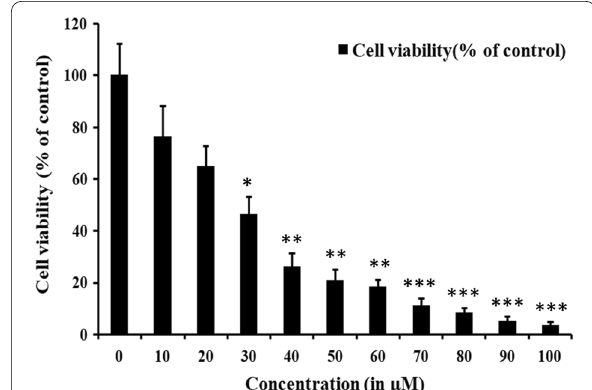
Fig. 3 Effect of Garcinol on cell proliferation and viability of RAW 264.7 cells. Cells were treated with increasing concentrations of Garcinol for 24 h; cell viability was determined with MTT cell proliferation reagent. Results were expressed as cell viability (% of control). All data are expressed as mean SEM (n 3). * p < 0.05, ± = ** p < 0.01 and *** p < 0.001 vs. 0 μM. The IC 50 was calculated to be 24